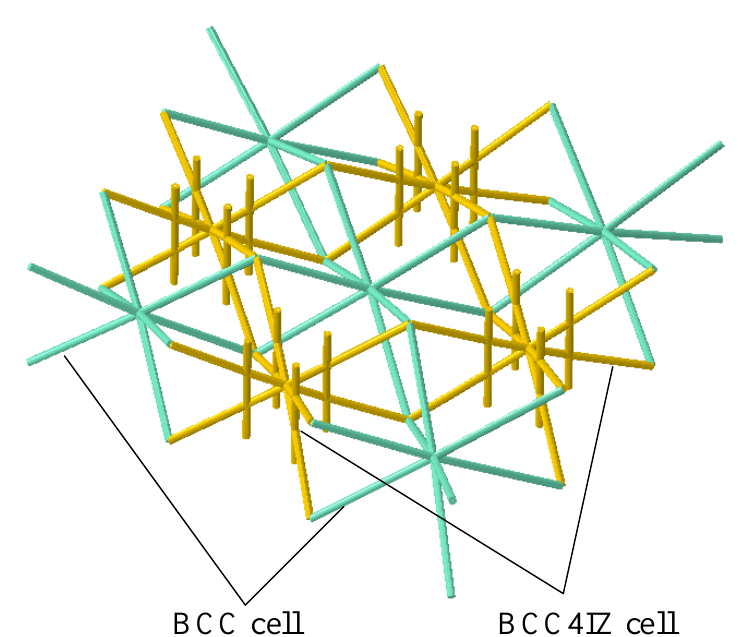
Figure 14. Alternative layout of the lattice cell structure of